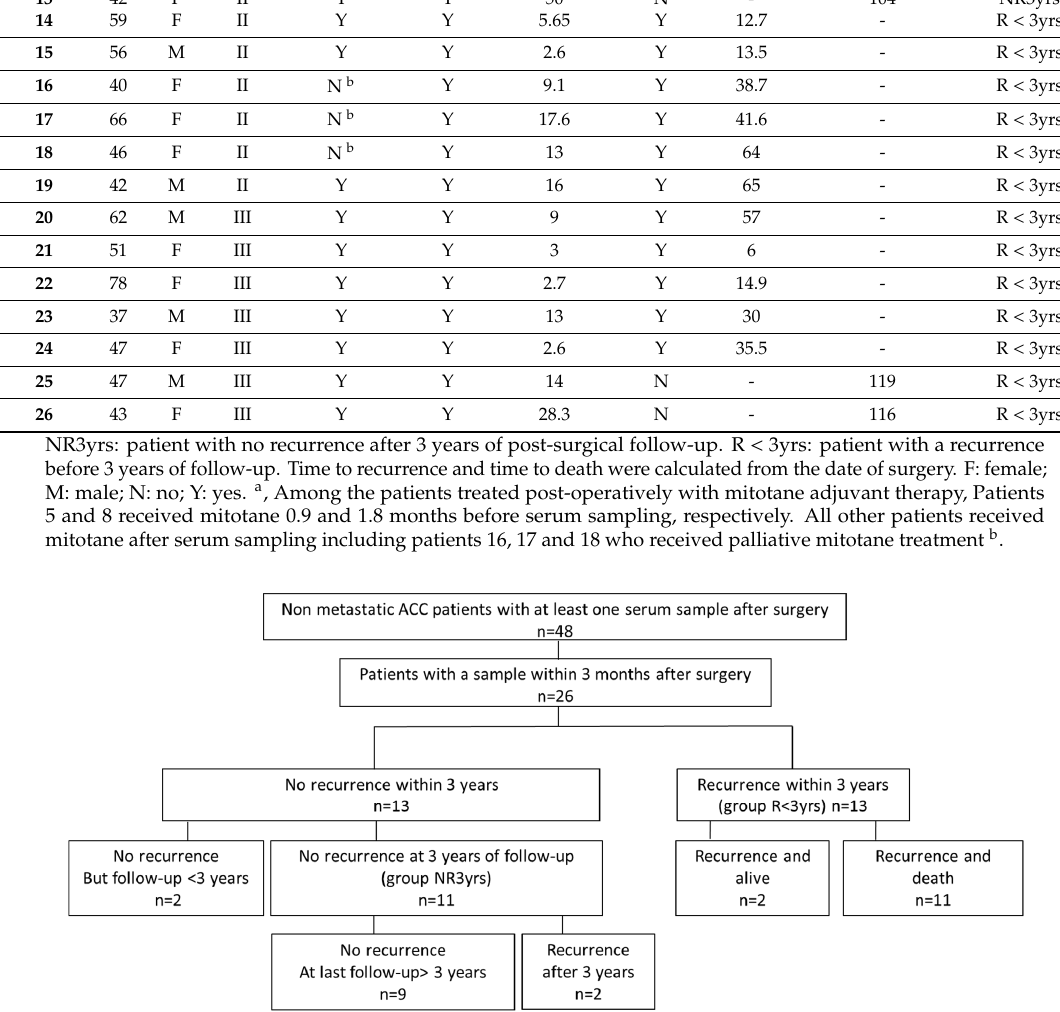
Table 1. Clinical characteristics of the 26 patients with adrenocortical cancer (ACC) with serum sampled within 3 months after